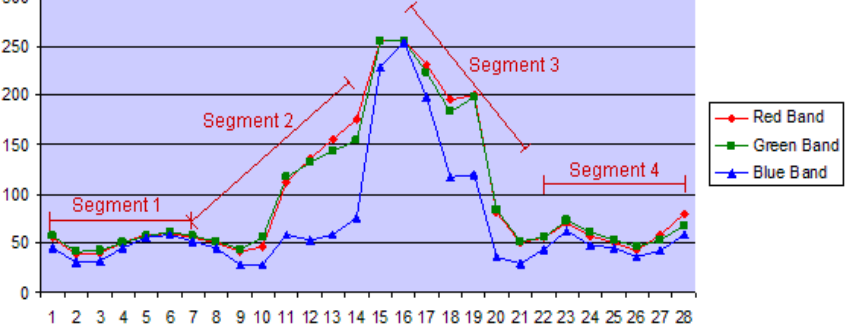
Figure 6. An example of the color segments along the 45 degree